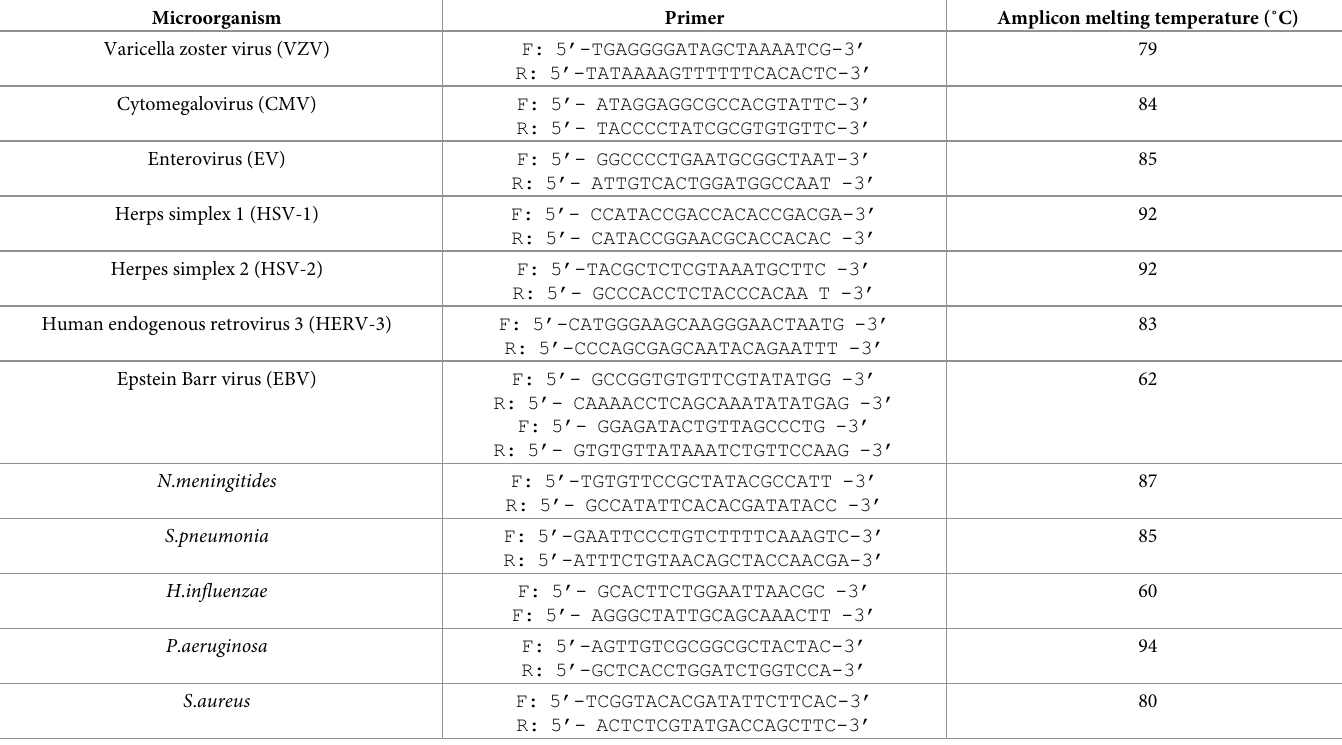
N.meningitides: Neisseria meningitides. S.pneumonia: Streptococcus pneumonia. H.influenzae: Haemophilus influenzae. P.aeruginosa: Pseudomonas.aeruginosa. S.aureus: